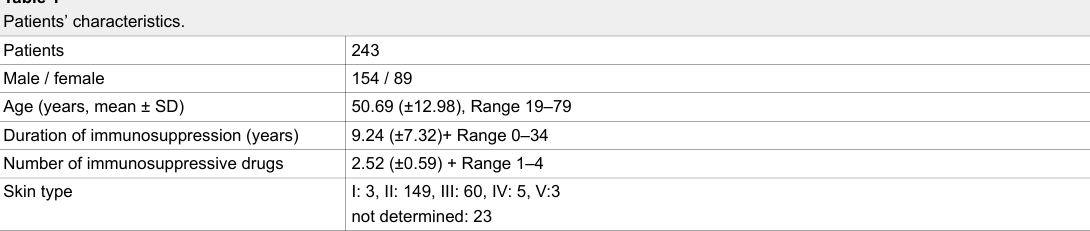
Table 2 Regimens of immunosuppressive therapy.